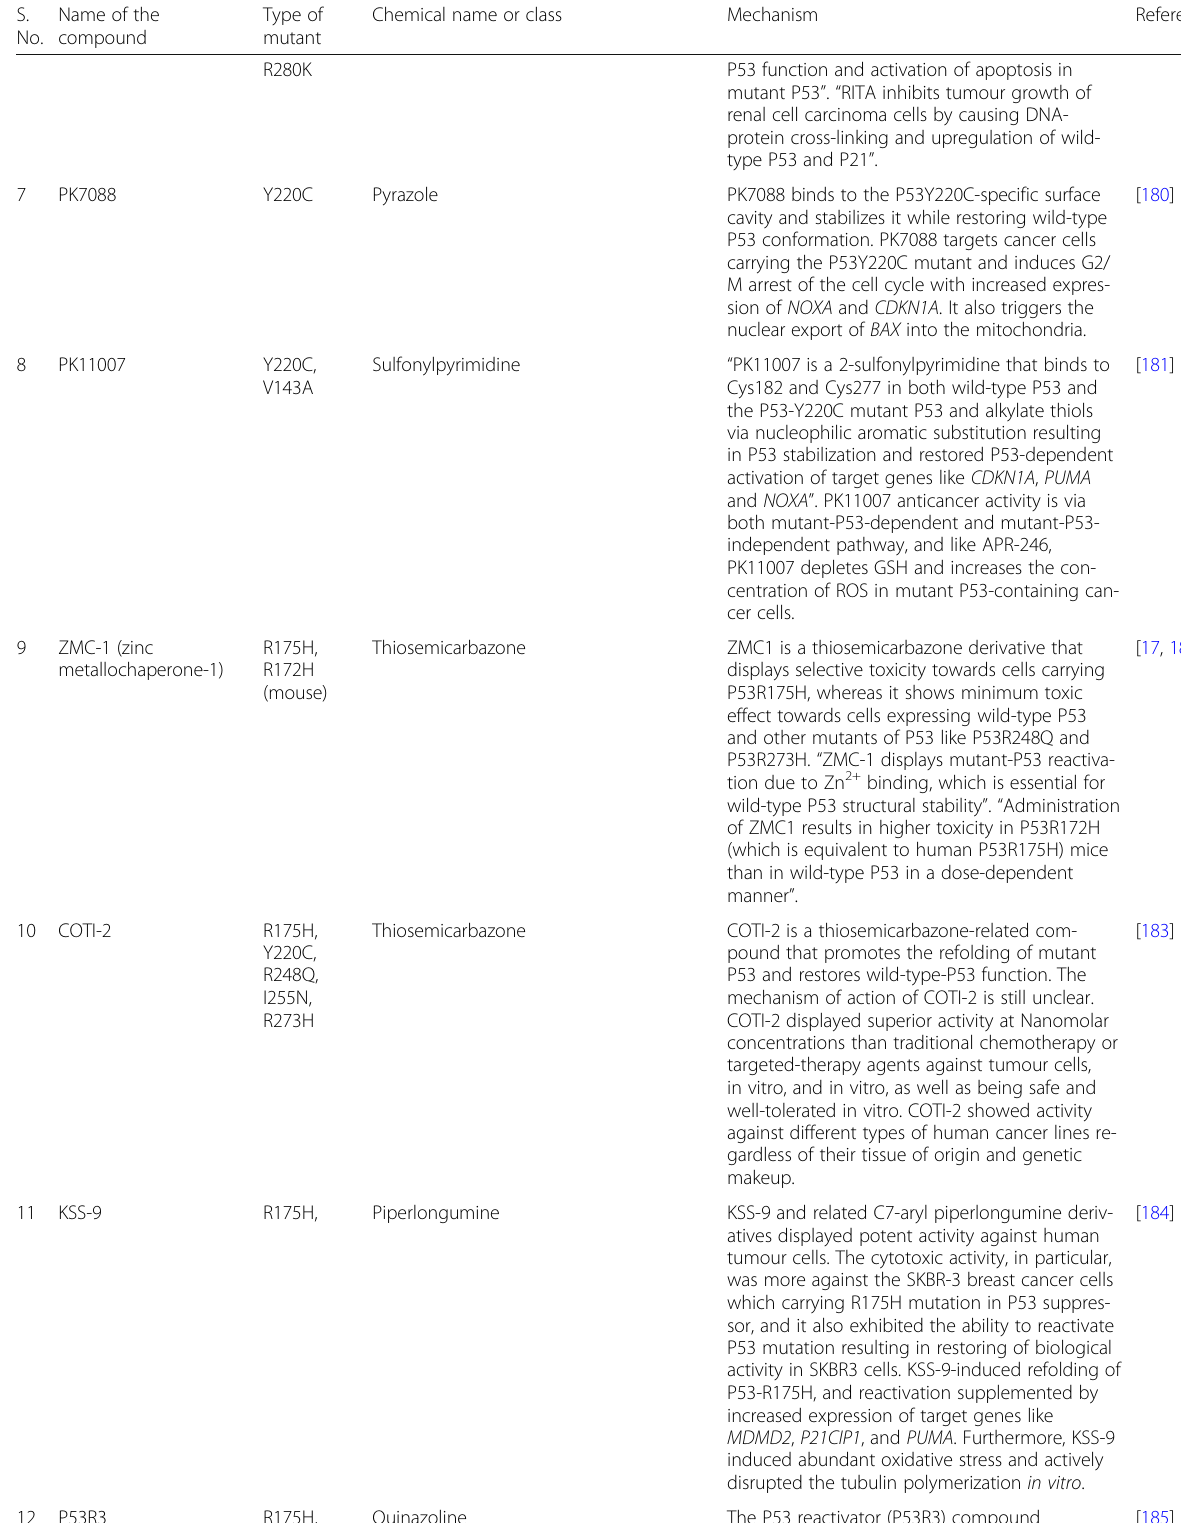
Table 1 Compounds that target mutant P53 and induce reactivation